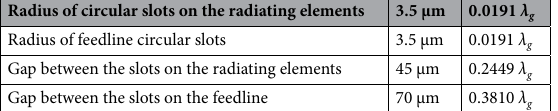
Table 2. Dimensions of the slots (in microns &